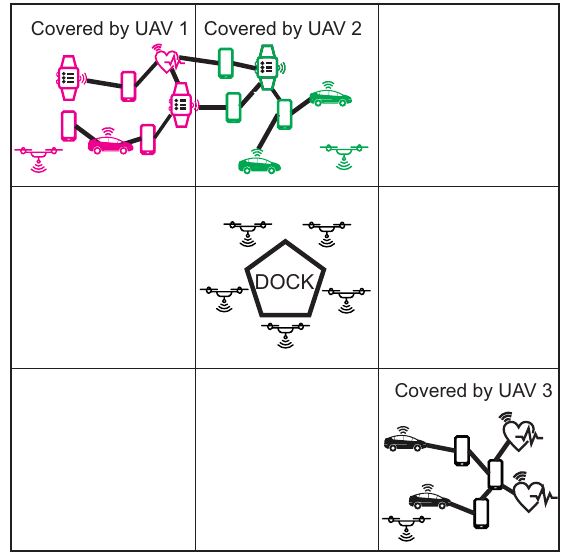
Figure 11. Example of multiple encountered cluster in the